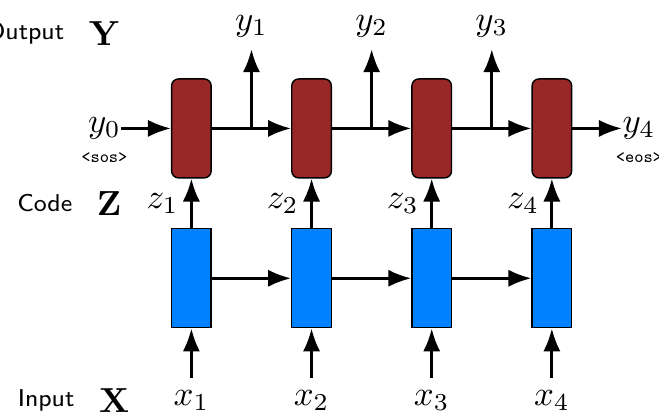
Figure 4. A basic encoder–decoder architecture. Blue: Encoder. Red: Decoder. Given an input